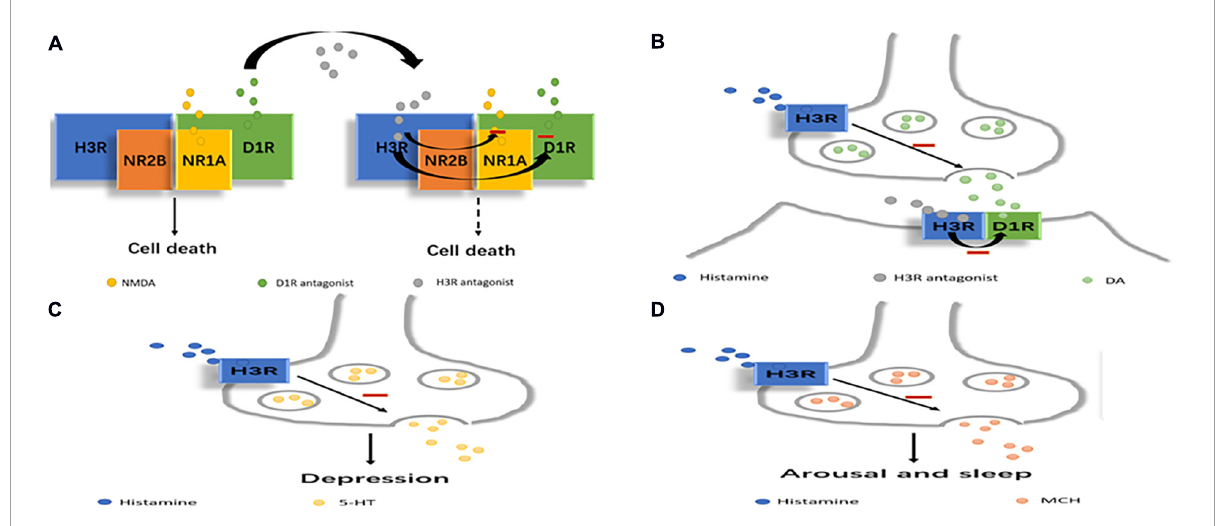
FIGURE1 Scheme depicting how histamine may regulate other transmitters related to depression. (A) H3R antagonists can reduce NMDA or D1 receptor-mediated excitotoxic cell death by the D1R-H3R-NMDAR heterocomplex. (B) D1R-H3R heteromer can integrate DA- and histamine-related signaling which can be inhibited by H3R antagonists. (C) H3R can affect depression by directly inhibiting 5-HT release. (D) H3R can affect arousal and sleep by directly inhibiting MCH